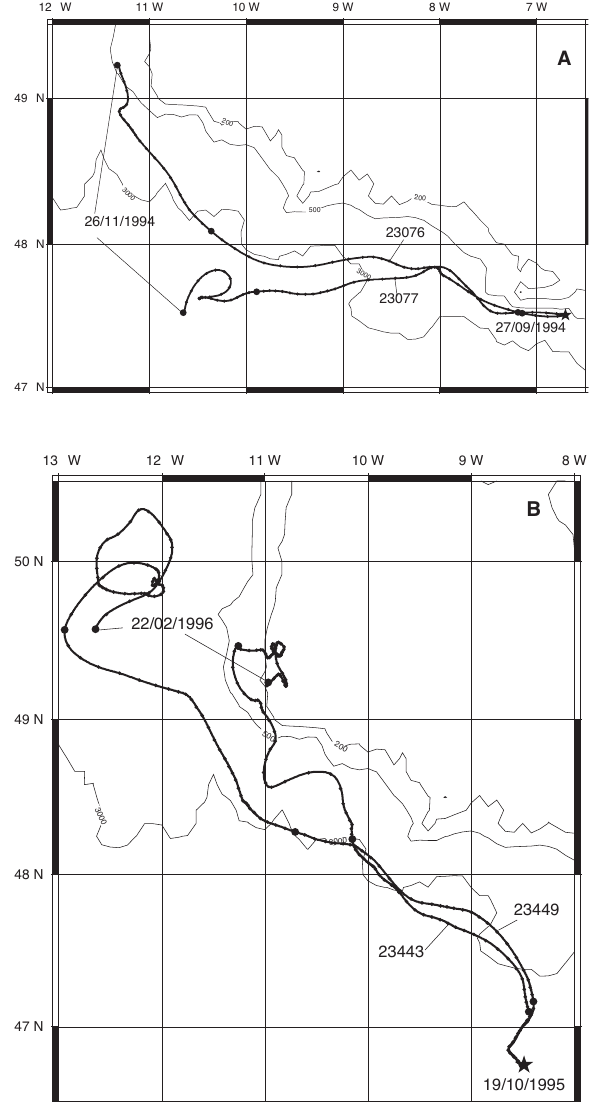
F IG . 3. – Low-pass filtered trajectories of Surdrifts 23076 and 23077, drogued at 80 m, and launched on 27 September 1994 (A) and Surdrifts 23443 and 23449, drogued at 150 m, and launched on 19 October 1995 (B) at the same location (indicated by a star). Small black dots indicate days and unlabeled bigger black dots indicate beginning of